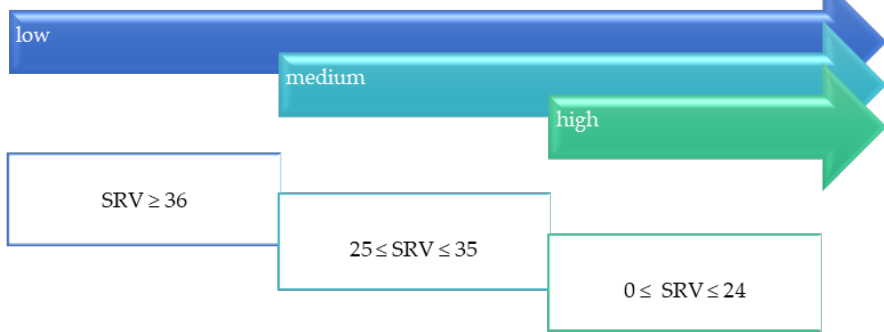
Figure 2. Slip risk in relation to slip resistance value